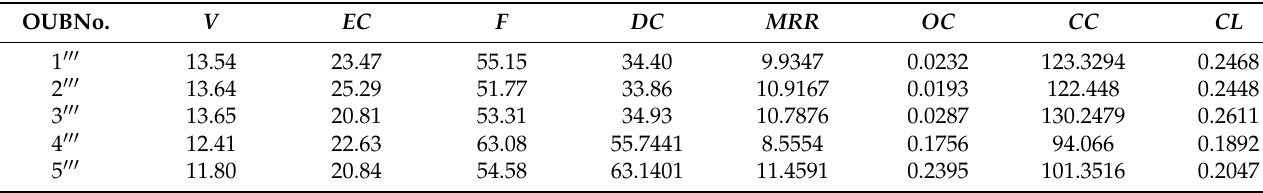
Table A16. Outcome of unemployed bee solutions.